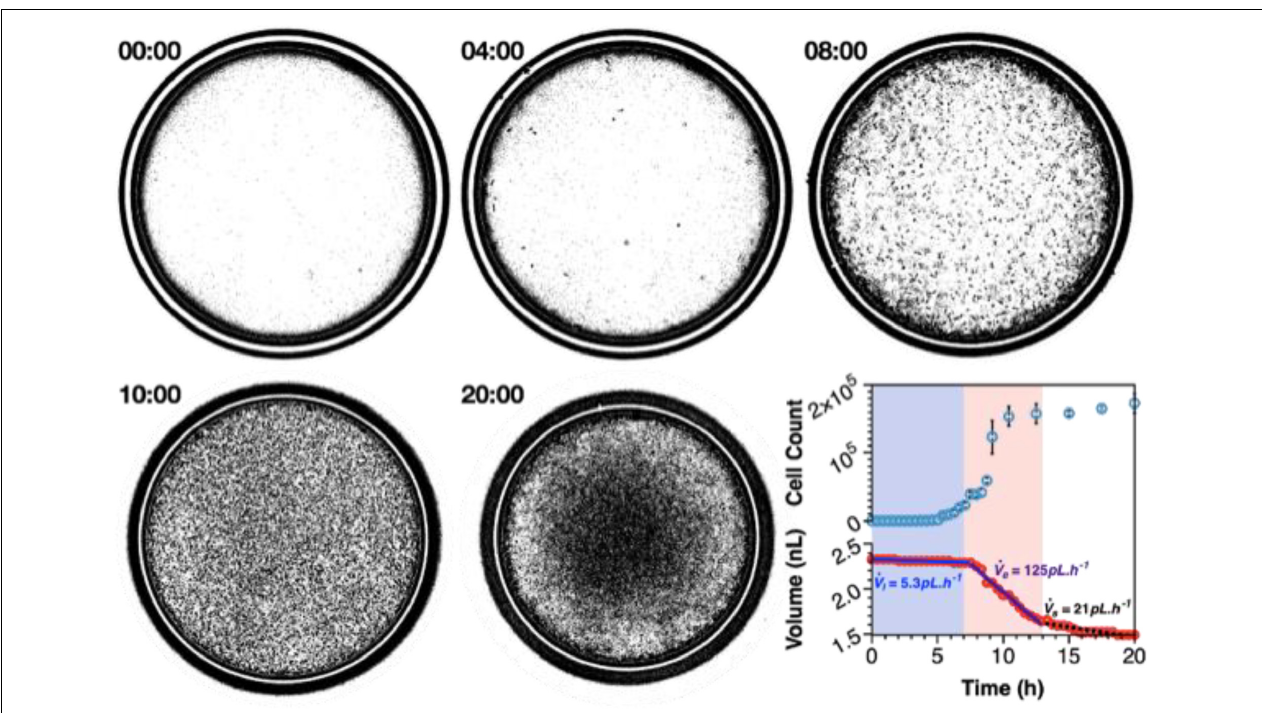
FIGURE 4 | Nanocultures provide an ideal environment to study microbial growth dynamics over spatial-temporal scales that recapitulate that of macroscale flask cultures. Growth of P. aeruginosa was observed over the course of 20 h, whereby exponential growth is achieved between 7 and 13 h and stationary phase is attained after 13 h of incubation. The nanocultures shrink in size due to consumption of resources, and the volumetric flowrate of water leaving the capsules may be calculated at each stage by observing the decrease in capsule diameter in real-time (Usman et al.,